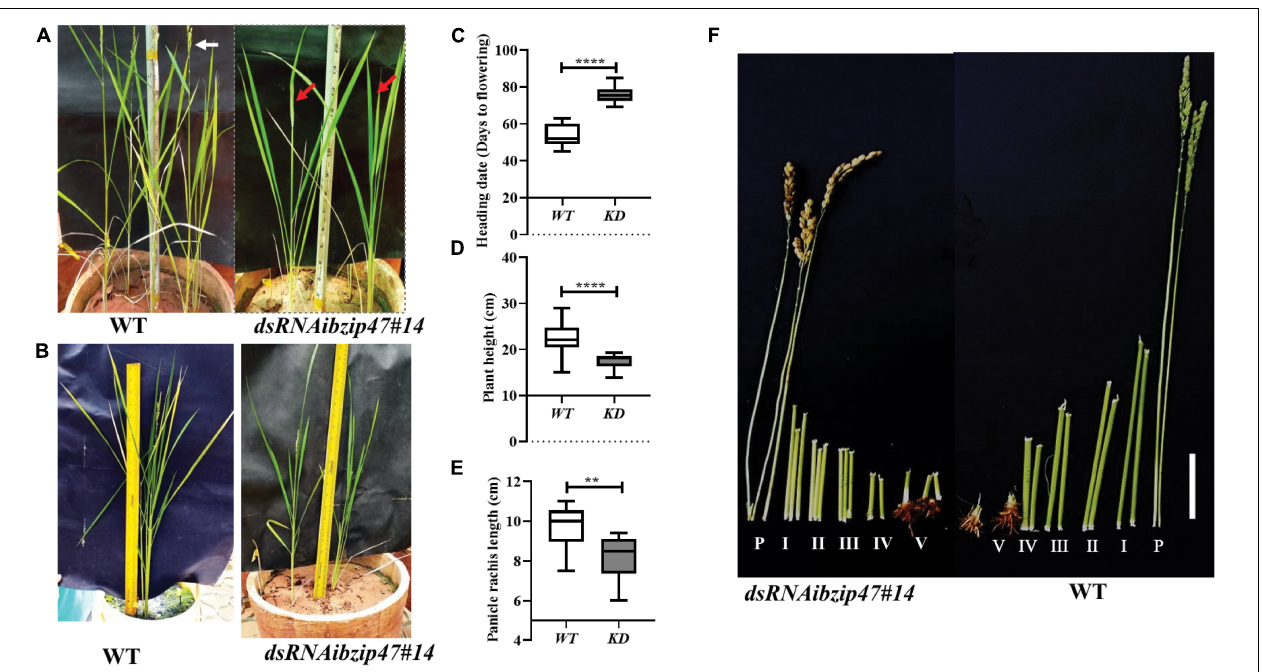
FIGURE 2 | Phenotypic effects of OsbZIP47KD on plant growth and floral transition. (A) Flowering timing (SAM to inflorescence meristem (IM)/panicle meristem transition) in OsbZIP47KD plants is delayed by approximately 22 days as compared to the WT. White arrow indicates the booted panicle in WT and red arrow points to the absence of the booted panicle in a OsbZIP47KD plant of the same age. (B) Height of mature flowering plants shows that as compared to the WT, OsbZIP47KD plants are shorter. Quantitation of heading dates (C) , plant height (D) , and panicle rachis length (E) in WT and OsbZIP47KD plants. Data are shown as the mean ± s.d. (Student’s t -tests, ** P < 0.01, **** P < 0.0001, n = 10). (F) Internodes in mature flowering WT and OsbZIP47KD plants are displayed and are numbered from I to V from the apical end. P is the panicle bearing node and internode. Bar, 2.5 cm. Shorter internodes from I to V in OsbZIP47KD contributes to the reduced